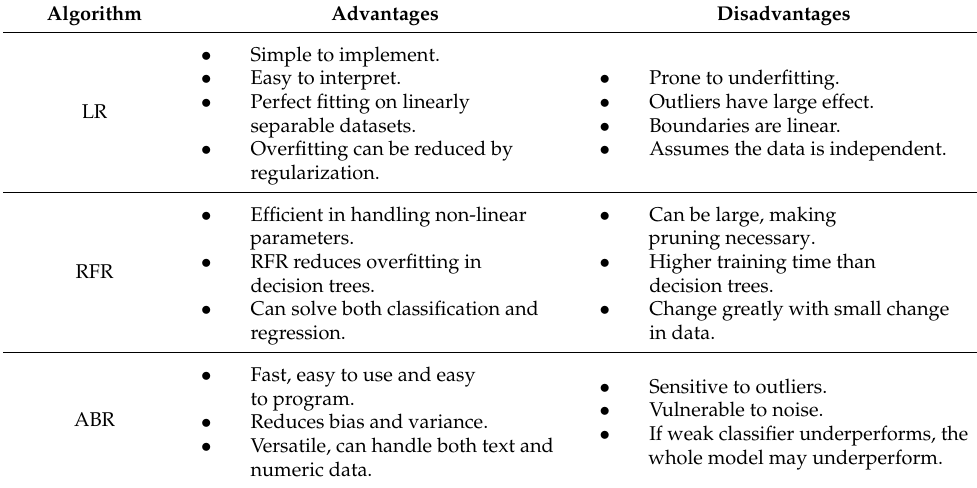
Table 2. Advantages and disadvantages of the LR, RFR and